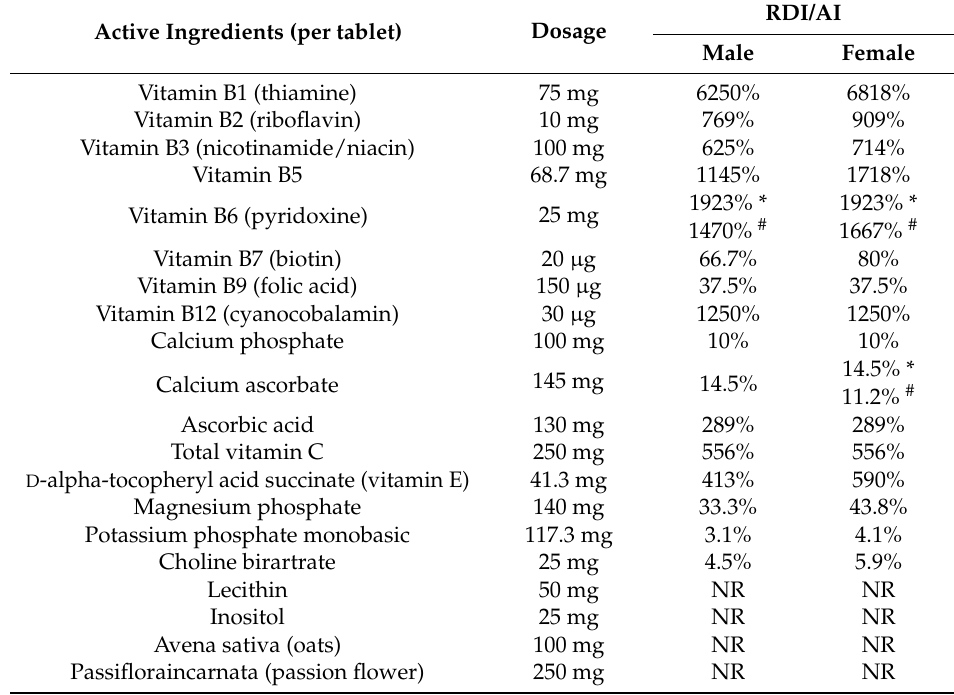
Table 2. Ingredients and doses of Blackmores ® Executive B